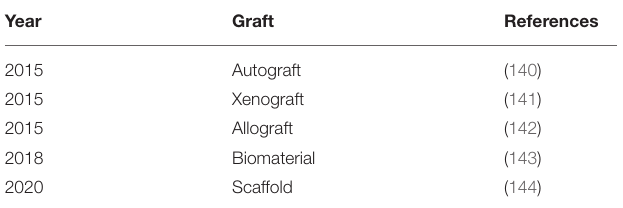
TABLE 3 | Research’s on tissue engineering treatment of tendon in recent